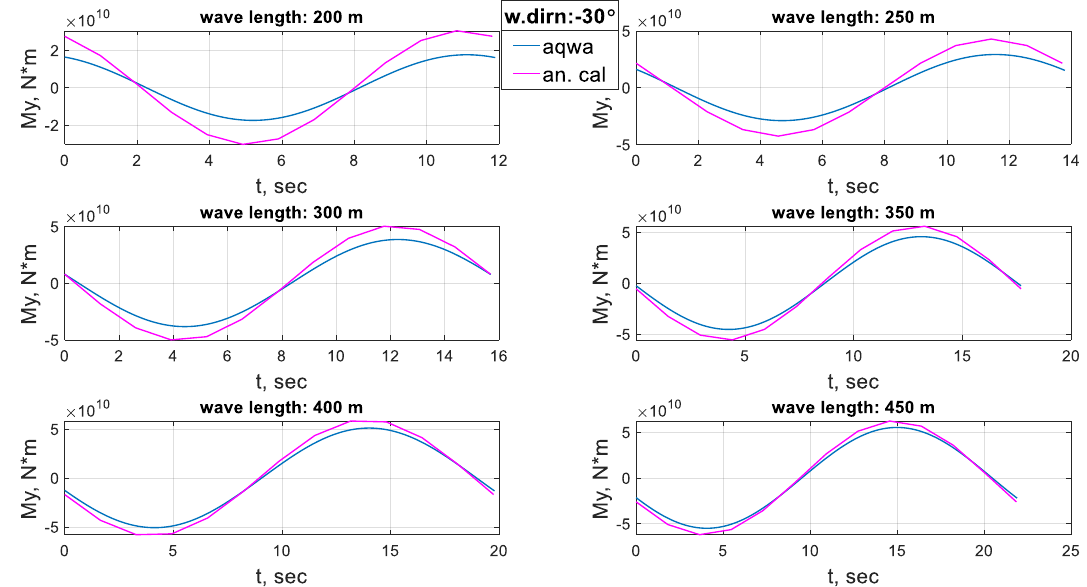
Figure 7. A comparison of vertical bending moments ( M y ). The incident wave splitting forces calculation by AQWA is in blue, while the hydrostatic wave load by analytic calculation is in magenta. From top to bottom, left to right: bending moment plots for wavelengths of 200 m, 250 m, 300 m, 350 m, 400 m, 450 m.